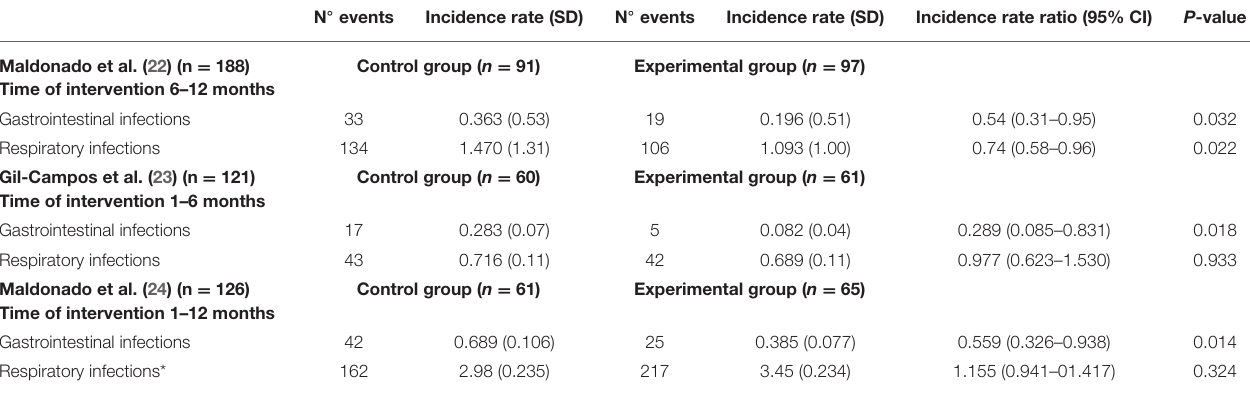
TABLE 1 | Summary of the incidence of gastrointestinal and respiratory infections in infants.